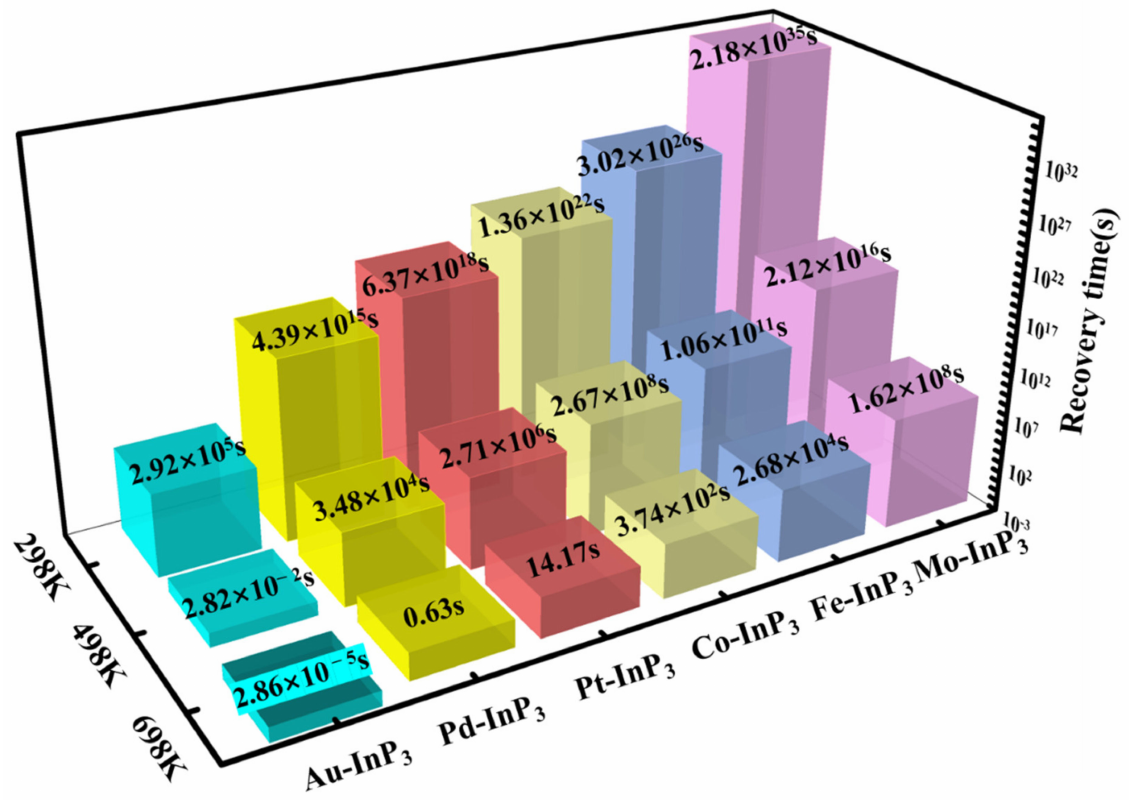
Figure 7. Recovery time of TM-InP 3 monolayers toward SO 2